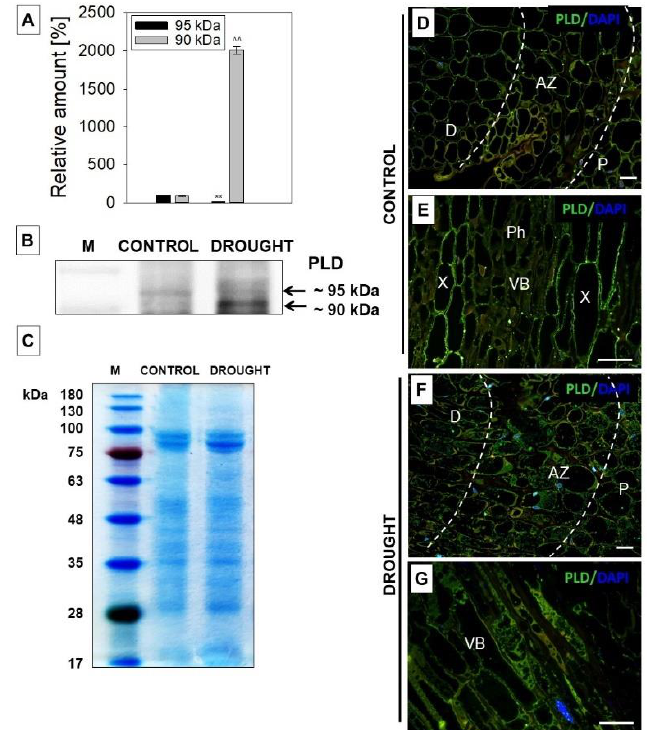
Figure 2. The level of phospholipase D (PLD) in the flower abscission zone (AZ) of Lupinus luteus is strongly affected by soil drought. For the analyses, flowers’ AZ fragments were collected on the 48th day of cultivation from drought-treated lupines (25% water holding capacity, WHC) or control plants (70% WHC). For details, see the Material and Methods section. Western blot analysis was performed with an anti-PLD antibody and revealed the presence of two reactive bands of ~90 kDa and 95 kDa ( B ). These bands were scanned, and densitometry data were generated (100% was set for the control ( A ). Results on the chart are presented as means ± SE. A significant difference in AZ from drought-treated plants in comparison to control for the isoform of ~95 kDa are ** p < 0.01, while for the isoform of ~90 kDa are ^^ p < 0.01. Coomassie brilliant blue-stained SDS-PAGE gel ( C ). Molecular mass marker (M), sizes are shown in kDa. Immunolocalization of PLD in flower AZ of control ( D , E ) and drought-stressed lupines ( F , G ). Green fluorescence indicates the presence of PLD, whereas blue labeling corresponds to nuclei stained with DAPI. AZ region is marked by white dotted lines. Images ( E ) and ( G ) are magnified regions of the central area of AZ containing vascular tissues from control and stressed plants, respectively. Abbreviations: AZ — abscission zone; D — distal region of AZ; P — proximal region of AZ; Ph — phloem vessels; VB — vascular bundle, X — xylem vessels. Bars = 40 µM.